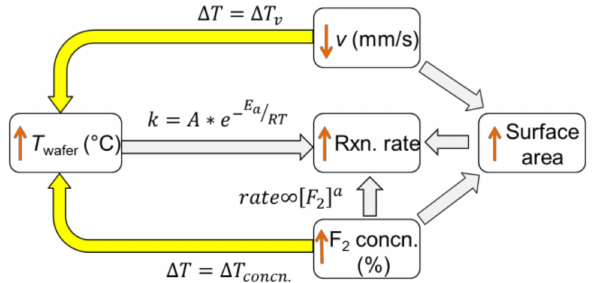
Figure 11. Schematics showing the influence of increasing concentration of the reactant (F 2 ) and increasing process duration (lowering v ) on the resulting temperature and reaction rate of the exothermic reaction system we are analysing here. Here, the temperature dependence of the rate constant ( k ) is shown by the Arrhenius equation with A as pre-exponential factor, E a as activation energy, and R as the ideal gas